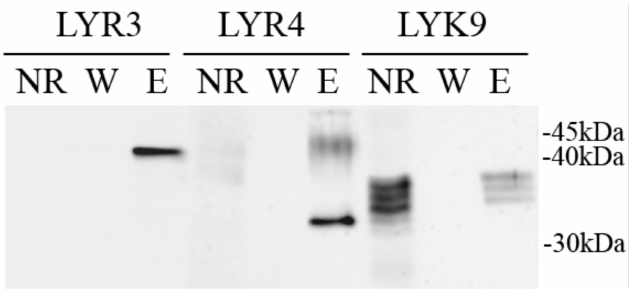
Figure 5. Purification of the Ps LYK9-ECD, Ps LYR4-ECD and Ps LYR3-ECD extracellular domains from insect cells using µ MACS columns containing the MicroBeads with immobilized anti-HIS antibodies. Elution was carried out with triethylamine. NR—non-retained fraction, W—washing, E—elution.